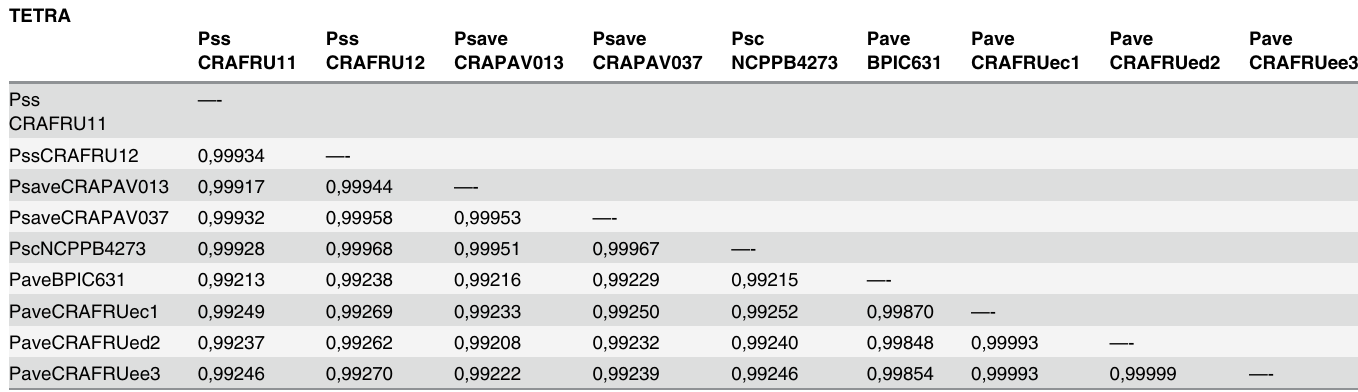
Table 3. Tetranucleotide frequency correlation coefficients (TETRA) values calculated between genomes of nine Pseudomonas strains causing disease to Corylus avellana trees (see also Table 2). TETRA Pss CRAFRU11